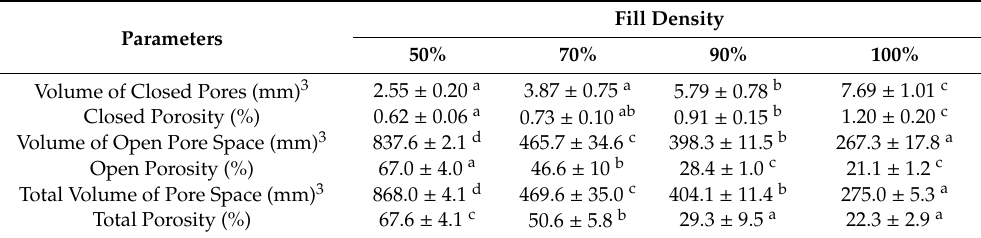
Table 2. 3D analysis of binary images performed by CTAn scanning software.